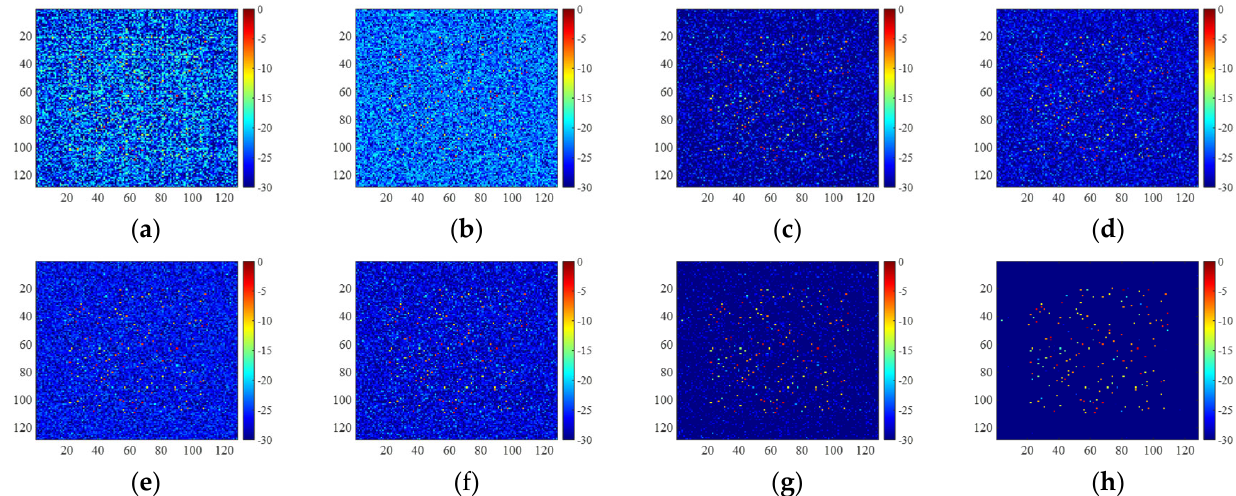
Figure 21. Images of 2D-ADN at different stages: ( a ) n = 1, ( b ) n = 2, ( c ) n = 3, ( d ) n = 4, ( e ) n = 5, ( f ) n = 6, ( g ) n = 7, ( h ) n = 8 .